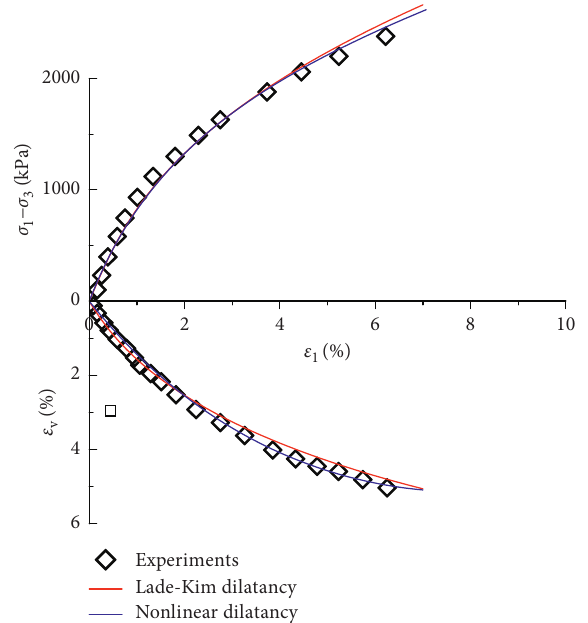
Figure 19: Model prediction results for constant stress increment ratio experiments.